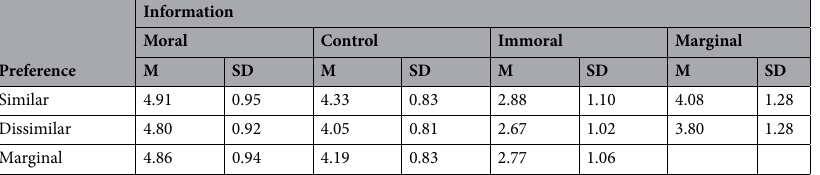
Table 2. Means and standard deviations for the moral character judgments in Study 2. M and SD represents mean and standard deviation,